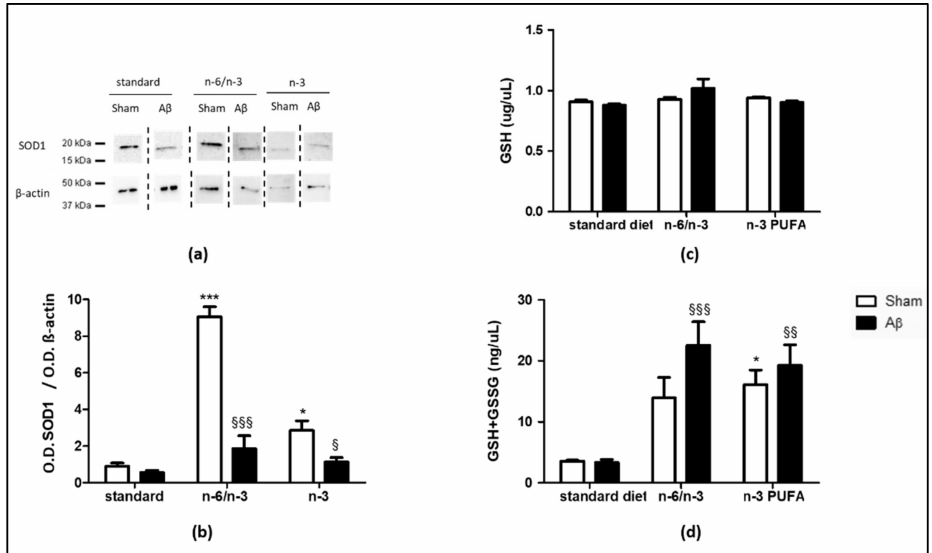
Figure 3. Effects of standard, n-6/n-3 PUFA balanced and n-3 PUFA enriched diets on SOD1, GSH and GSH+GSSG levels in A β -treated rats. Representative image of Western blotting ( a ) and quantification of the optical density ( b , SHAM standard n = 3, A β standard n = 4, SHAM n-6/n-3 n = 3, A β n-6/n-3 n = 4, SHAM n-3 n = 4, A β n-3 n = 4) of SOD1 band normalized to the actin protein value in the hippocampus of rats 7 days after icv injection of A β (A β , 4 µ M, black bar)